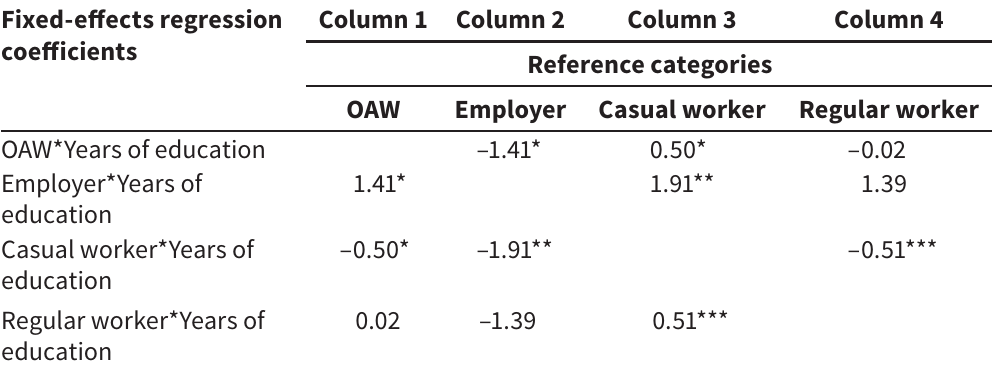
Fixed-effects regression coefficients for the interaction between sectoral choice and